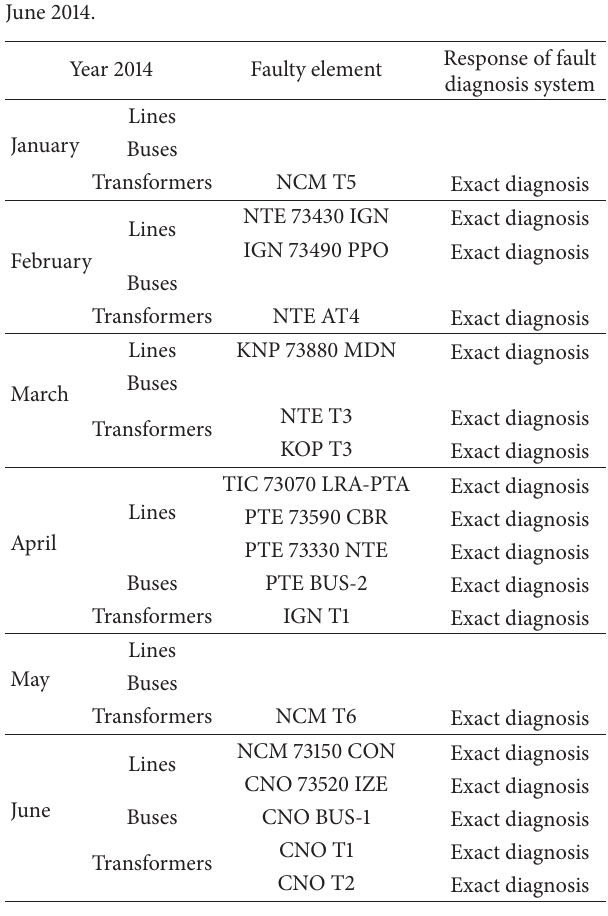
Figure 12: Fault diagnosis system structure. Table 3: List of faults detected by the diagnostic system